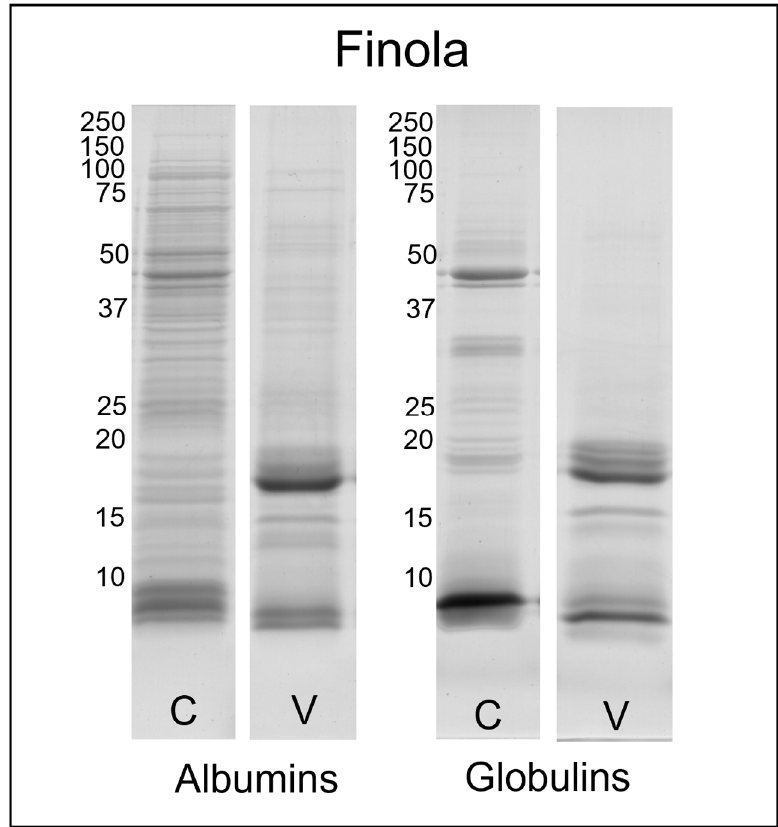
Figure 1. SDS-PAGE profile of albumin and globulin extracts obtained from Finola certified (C) and harvested seeds from the field of Viganella (V). The molecular weights (left) are expressed in kDa. Interestingly, the protein profile of seeds harvested from plants grown in the Viganella site differs from that of certified seeds, and this pattern is similar for both Finola and Secuieni J. seeds, but more pronounced in Finola extracts. In fact, both albumin and globulin fractions of harvested seeds showed fewer bands at high molecular weight, with the complete disappearance of bands previously detected at 48 and 35 kDa in Finola certified seeds. Meanwhile, more intense bands developed around 18–20 kDa and below 15 kDa with respect to certified seeds. These bands at lower molecular weight have been previously identified in Finola seeds as fragments of edestin [21]. Secuieni J. fractions from harvested seeds show a decrease in intensity of bands at 48 and 30–35 kDa, and a concurrent increase in those below 20